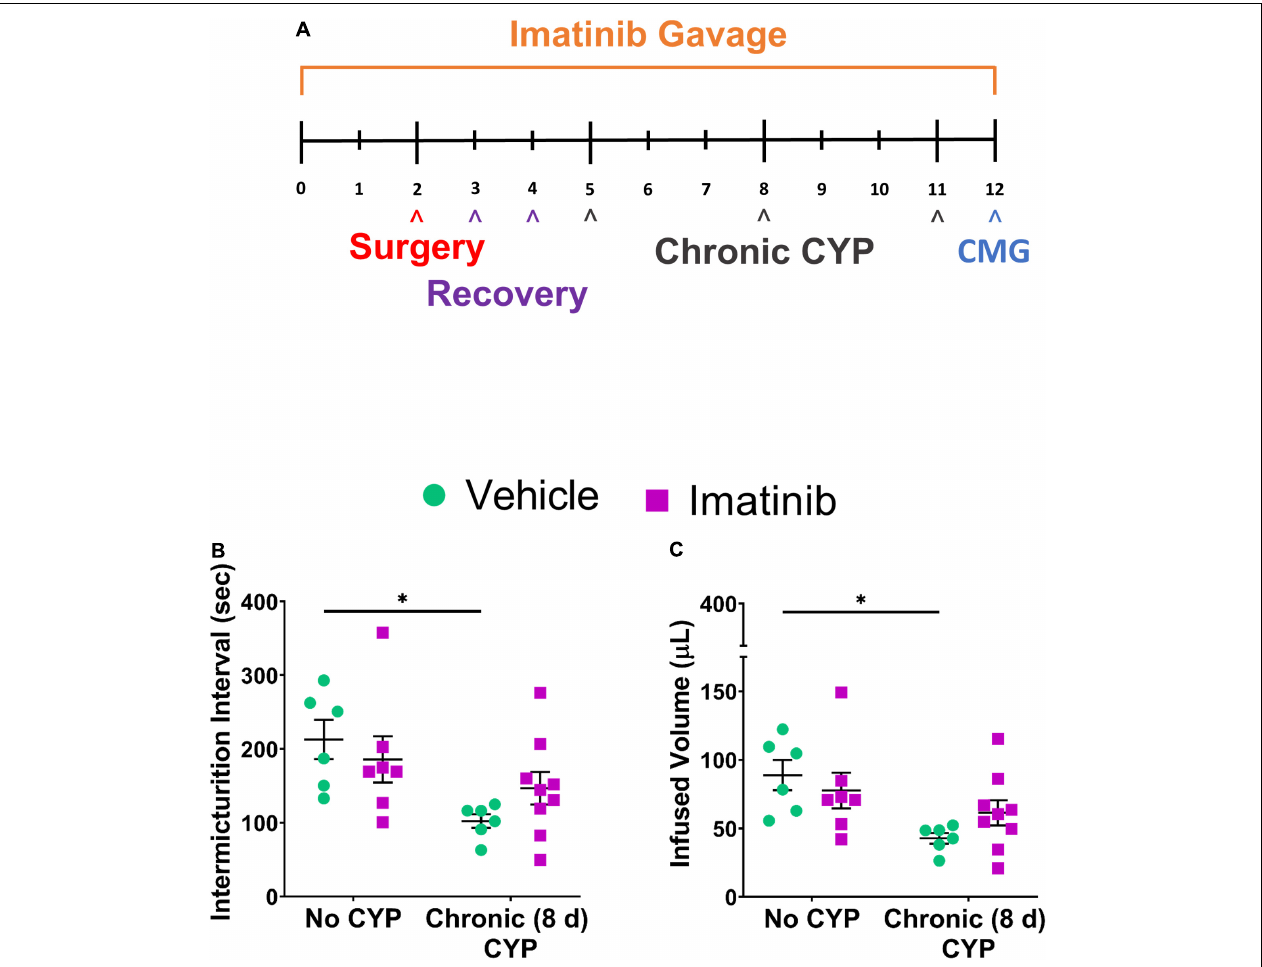
FIGURE 5 | Imatinib mesylate pre-treatment via gavage does not significantly affect bladder function in mice with chronic (8 day) CYP-induced cystitis. (A) Chronic CYP-induced cystitis (75 mg/kg, every 72 h for 8 days) experimental schedule for imatinib mesylate pre-treatment via oral gavage (250 mg/kg, 1X/day). (B,C) Imatinib pre-treatment via gavage did not significantly affect IMI or IV in female mice with chronic CYP-induced cystitis. n = 7–9. Values are mean ± SEM by two-way ANOVA with Bonferroni’s multiple comparisons test. CMG,